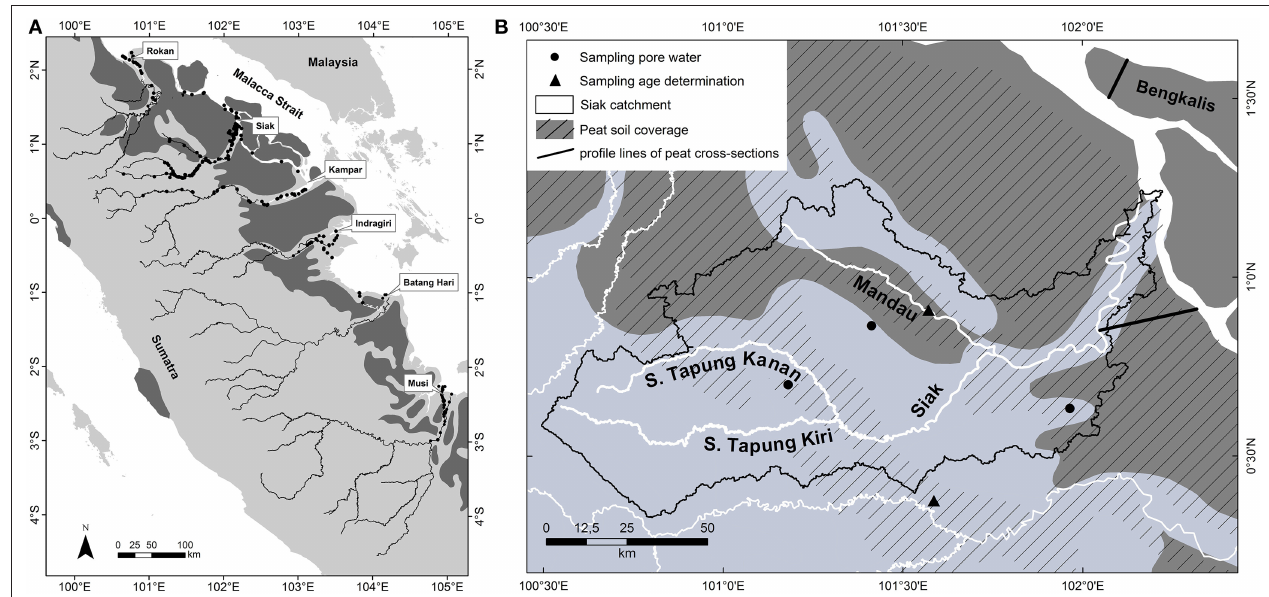
FIGURE 1 | (A) Major rivers including sampling sites (black circles), and peatlands (dark gray) in central Sumatra according to the digital soil map of the world (FAO, 2003). (B) A scale-up showing the Siak catchment in more detail. Black circles indicate the sites at which pore water samples were taken. Triangles mark the sites where water (DOC) and soil (peat) samples for radiocarbon age determinations were taken. The black lines are profile lines of cross-sections through the Siak and Bengkalis peat domes as shown in Figure 3C . The striped areas show the peatland distribution according to reference (Laumonier, 1997) which deviates from those of the FAO (dark gray). The map and scale-up were created using ArcGIS 9.3.1 software by